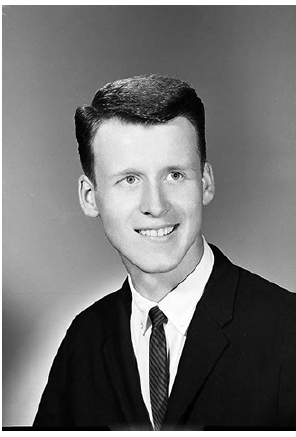
Figure 1: Roger Nelsen in 1963 when he was an undergraduate at DePauw